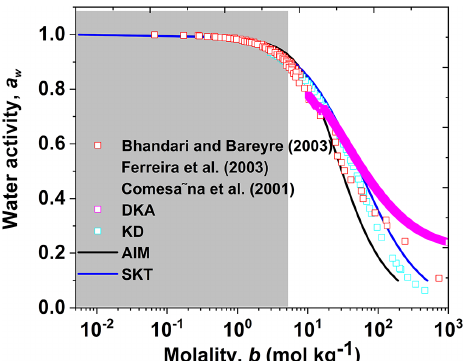
Figure 6. Concentration-dependent water activity ( a w ) of D- glucose solution. The DKA-derived a w (differential Köhler analy- sis, magenta open square) is compared with observations (red open square), E-AIM (Extend Aerosol Inorganic Model, black line), a w model (SKT, blue line), and the parameterization model for a w (KD: Kreidenweis, cyan open square). The light grey shaded areas mark the subsaturated concentration with respect to bulk solution.